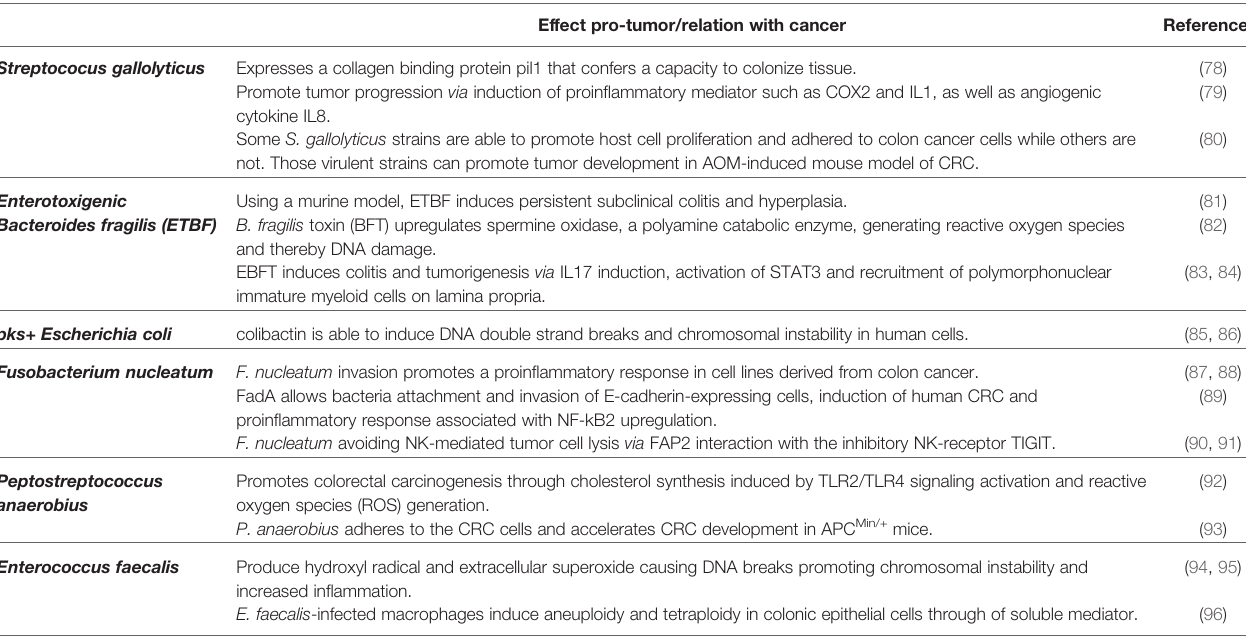
TABLE 1 | Bacteria involved in colorectal carcinogenesis.